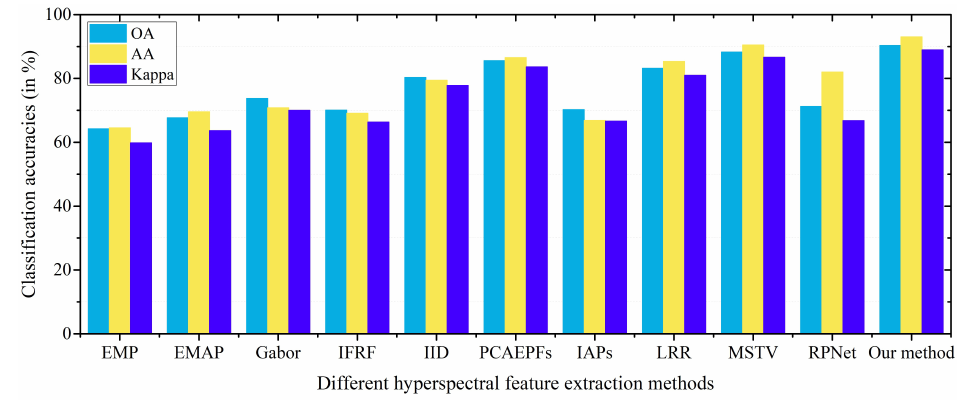
Figure 12. Classification accuracies of different hyperspectral feature extraction techniques on Indian Pines dataset.